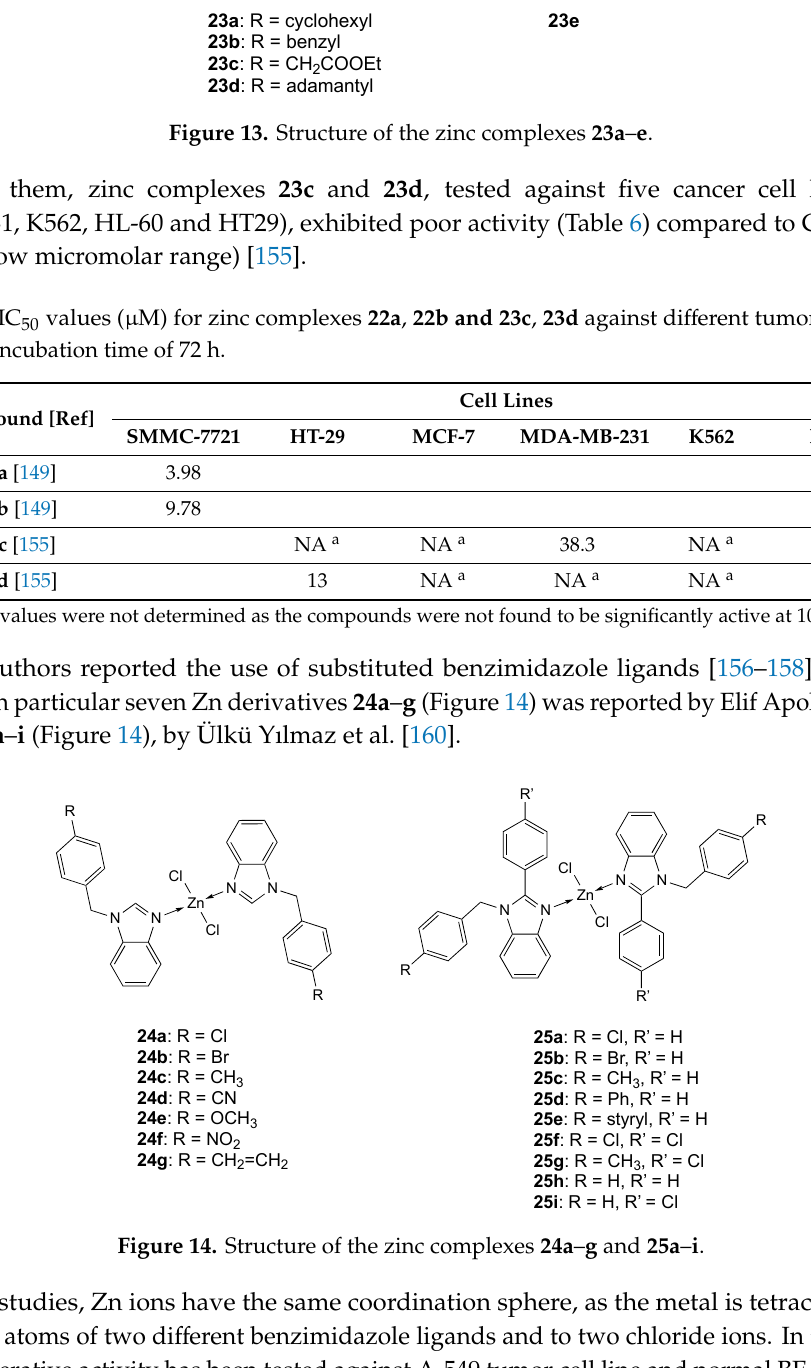
Figure 13. Structure of the zinc complexes 23a – e .